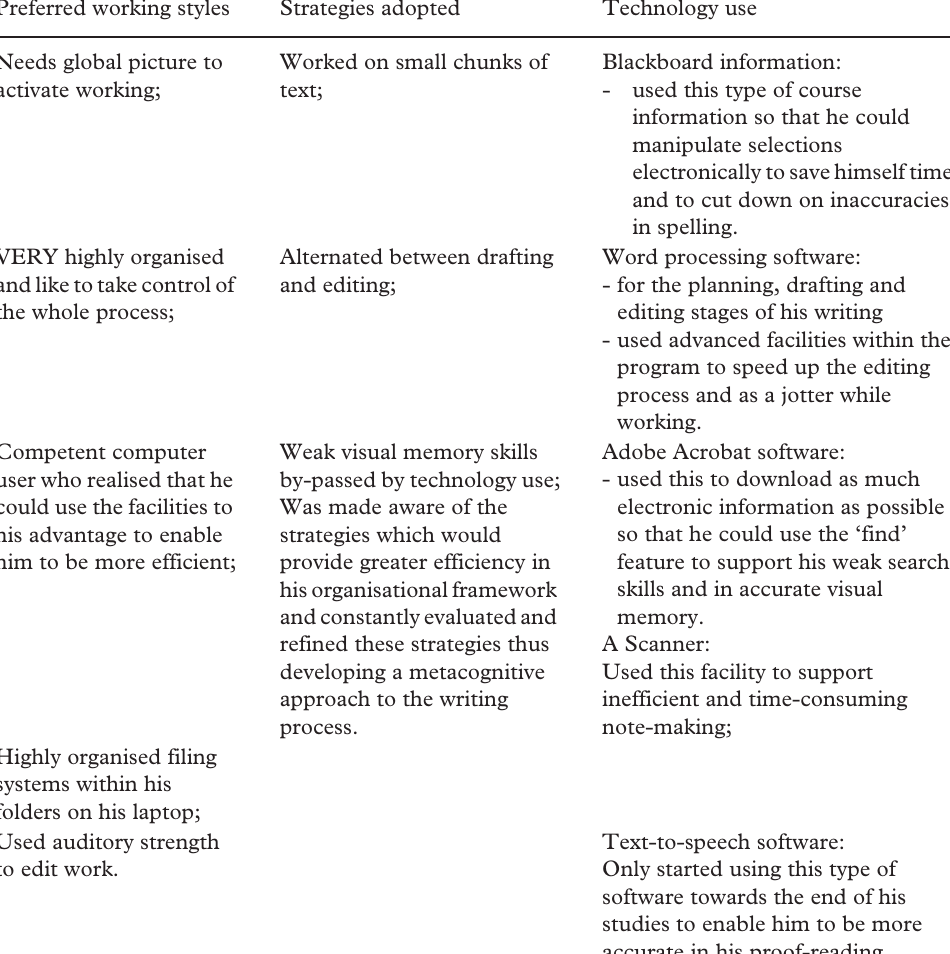
Table 2. Summary of strengths, technology and modal preferences of Student B Preferred working